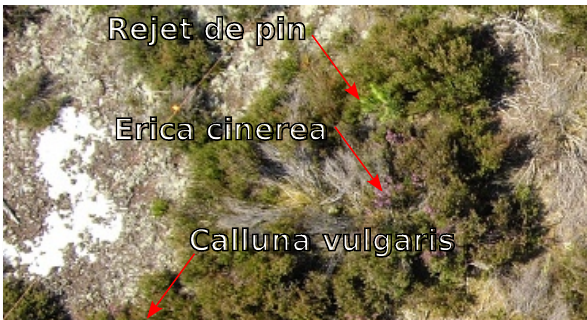
Figure 9: Very high resolution image with millimeter GSD that allows visual identification of species by botanists.